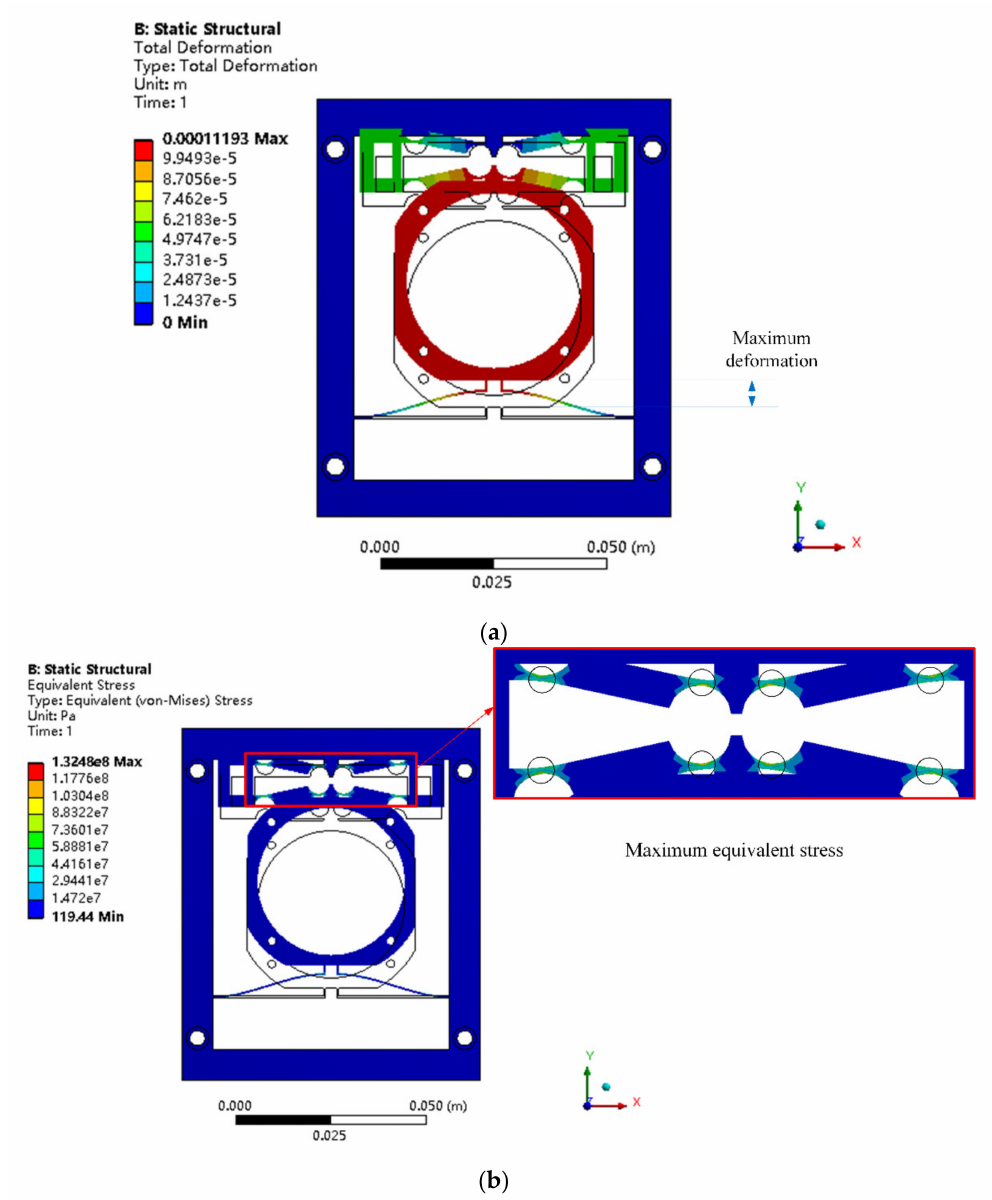
Figure 10. ( a ) Deformation and ( b ) equivalent stress of the FEM model of the piezoelectric